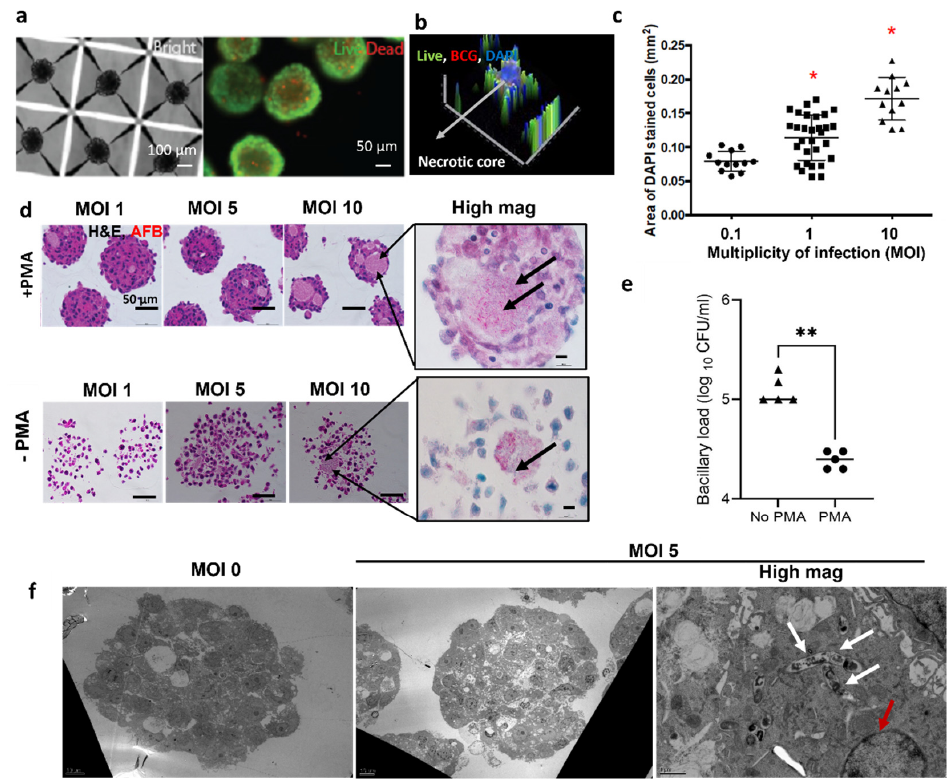
Figure 1. Modelling the TB spheroid infection in vitro. ( a ) Imaging of THP-1 TB spheroid using bright field, live (Calcein AM, Green) and dead (Ethidium homodimer, red) stain. ( b ) A 2.5D intensity projection J774 spheroid infected with BCG mCherry, Calcein AM and DAPI (blue). Arrows indicate presence of DAPI stained cells in the center of TB spheroid ( c ) area of DAPI + dead cells in TB spheroids formed with J774 infected with increasing MOI of BCG mCherry quantified via Image J analysis. * Represents p < 0.05, by one-way ANOVA. ( d ) Images of 5 µm sections of TB spheroid cultured with and without phorbol 12-myristate 13-acetate (PMA), stained with H&E (host cells), and acid-fast bacilli (AFB, bacteria). Arrows in the high magnification images show the AFB (Red) staining for bacilli. ( e ) Bacterial CFU/mL estimated by culturing TB spheroid lysates ( n = 5 wells/condition). ** represents p < 0.01 by Student T -test. ( f ) Transmission electron microscope images of spheroid sections with and without BCG mCherry at MOI 5. White arrows in the high magnification image show the localization of BCG within a macrophage. Red arrow shows the presence of necrosis-like cells in the spheroid in the high mag image.